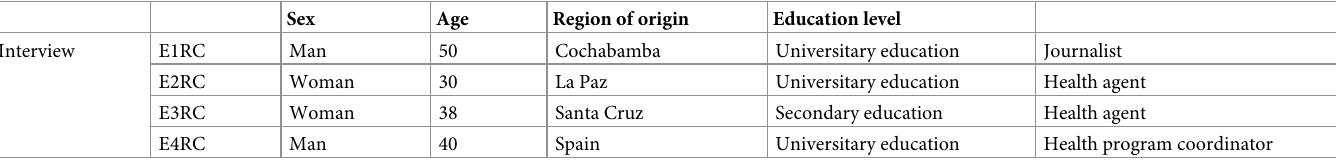
Table 3. Sociodemographic data of key